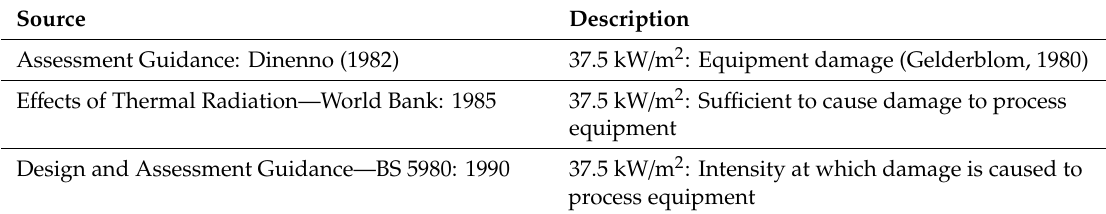
Table 1. Thermal radiation rating adversely a ff ecting chemical plant